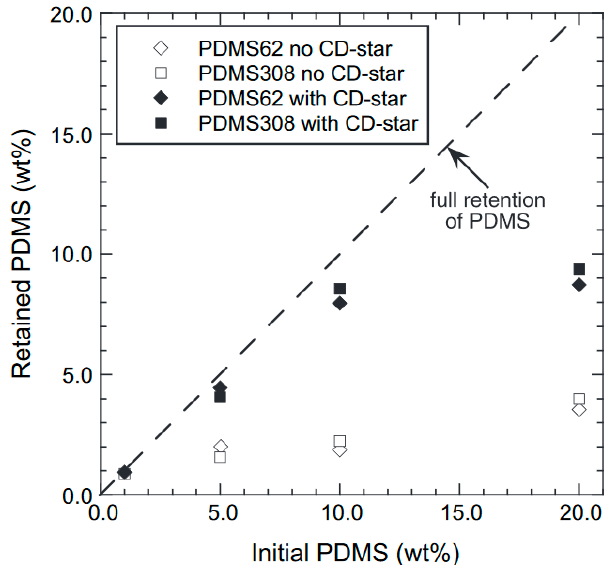
Figure 12. Retained poly(dimethyl-siloxane) (PDMS) (MWs = 62,000 and 308,000) vs. initial PDMS content for solution-cast films with and without γ –CD-stars. Films containing γ –CD-stars have a γ –CD core concentration of 1.0 wt %. Reproduced from [14] with permission, copyright Elsevier, 2010. Micrographs of spun-cast films containing varying amounts of PDMS with and without a 1 wt